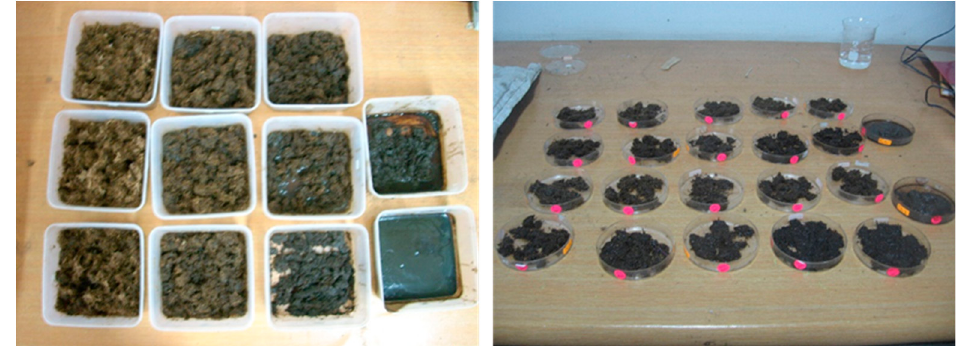
Figure 1. ( left ) Pre-composting phase for different POME-PPF mixtures (0%, 10%, 20%, 30%, …, 100%) ( n = 3 for each treatment). ( right ) Vermicomposting phase for different percentages of POME-PPF mixtures in Petri dishes ( n = 3 for each treatment).